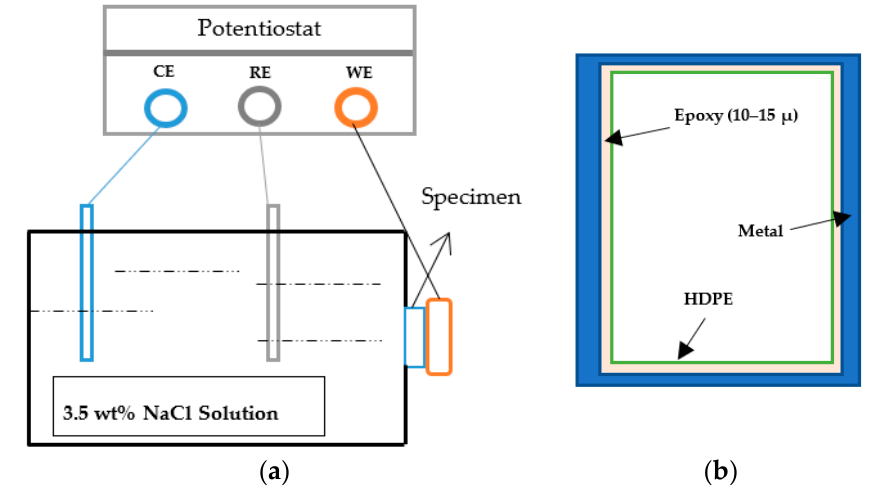
Figure 2. ( a ) Assembly of EIS setup, ( b ) prepared sample.